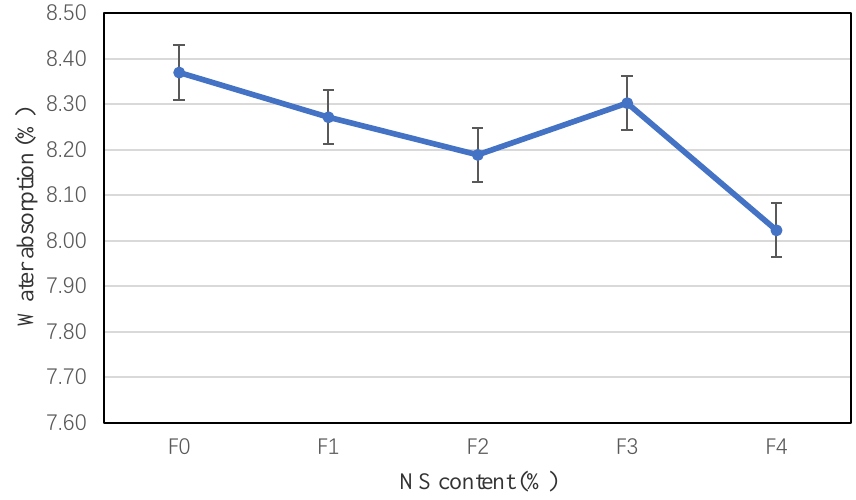
Figure 7. Water absorption of NS-modified mortar.